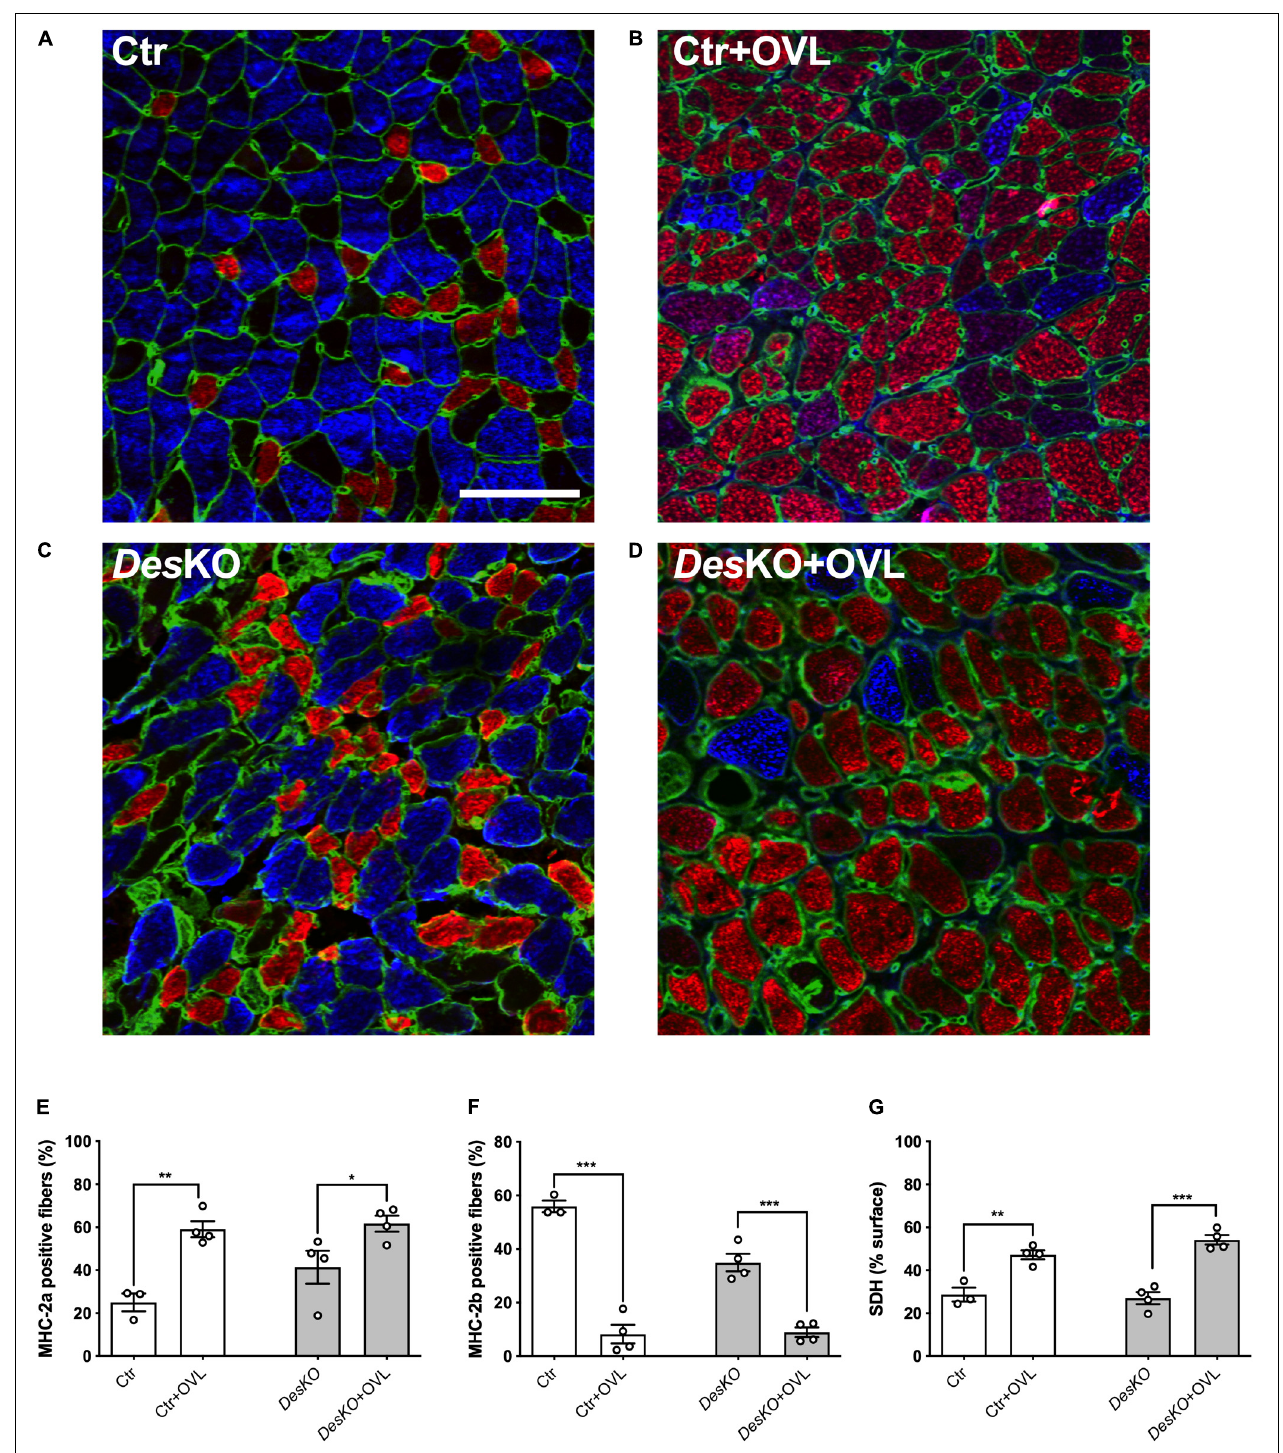
FIGURE 2 | Transition toward oxidative fibers is not impaired in DesKO plantaris in response to OVL. Representative images (A–D) of plantaris section immunostained for MHC-2a (red), MHC-2b (blue) and perlecan (green) from both genotype (Ctr and Des KO) in basal condition or after 1 month of OVL. Percentage of MHC-2a positive fibers (E) or MHC-2b positive fibers (F) . Percentage of the surface of muscle section demonstrating succinate dehydrogenase activity (G) . Scale bar = 100 µ m. Data are given as means ± SEM. Des KO, Desmin knock-out mice; Ctr, Control mice; OVL, mechanical overloading; MHC, myosin heavy chain; SDH, succinate dehydrogenase. ns : non-significant, * p < 0.05, ** p < 0.01, *** p < 0.001.